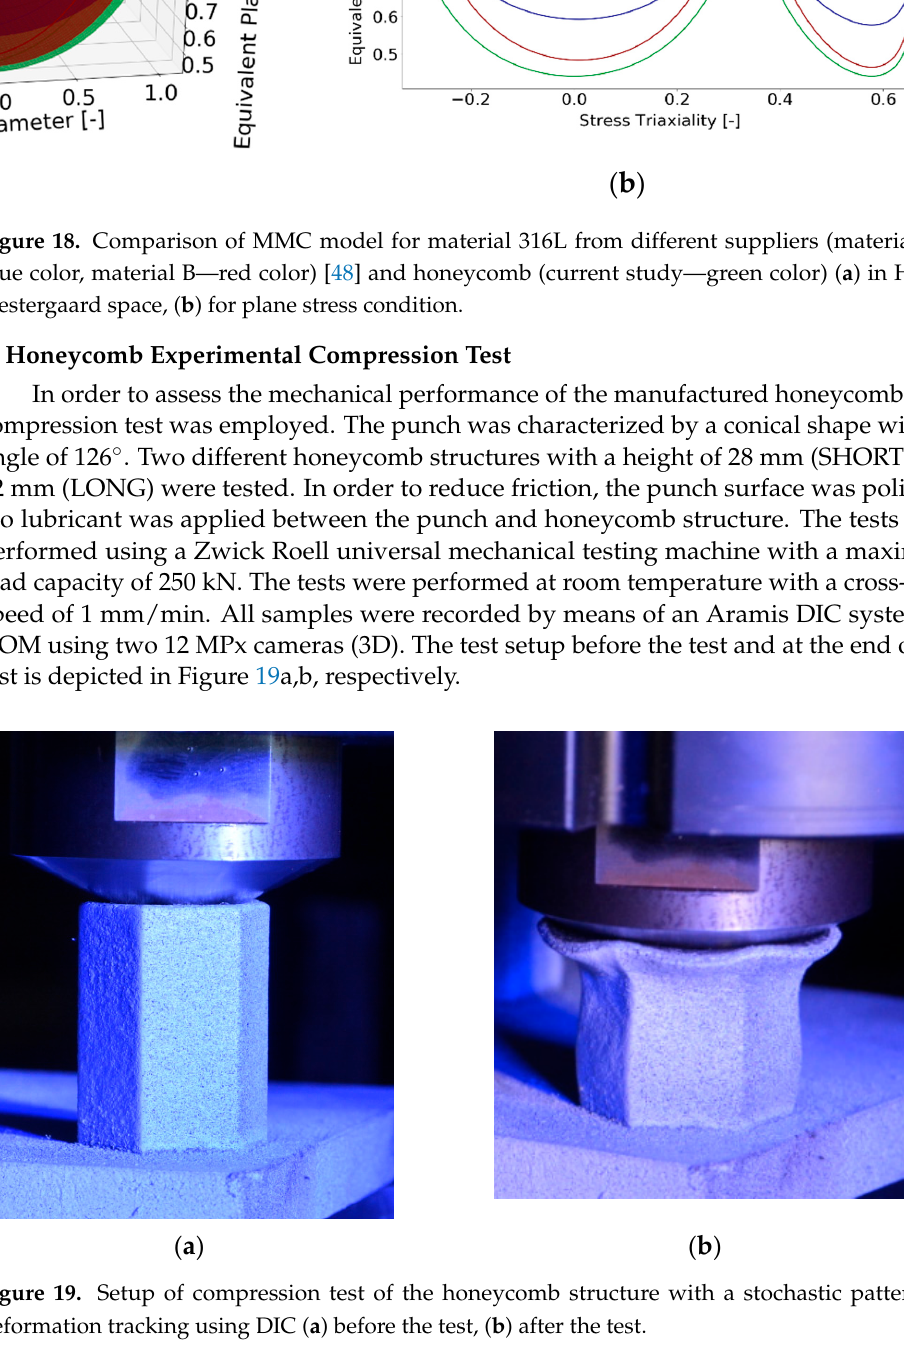
( b ) Figure 17. Fracture locus defined by MMC model of honeycomb ( a ) in Haigh-Westergaard space, ( b ) for plane stress condition. The fracture surface derived in this study was compared with the one published by Paredes et al. [47], where the mechanical tests of two conventionally produced austenitic steels 316L from different suppliers A and B were performed. For the fracture surface, they used the MMC model and all the parameters were published, namely the equivalent